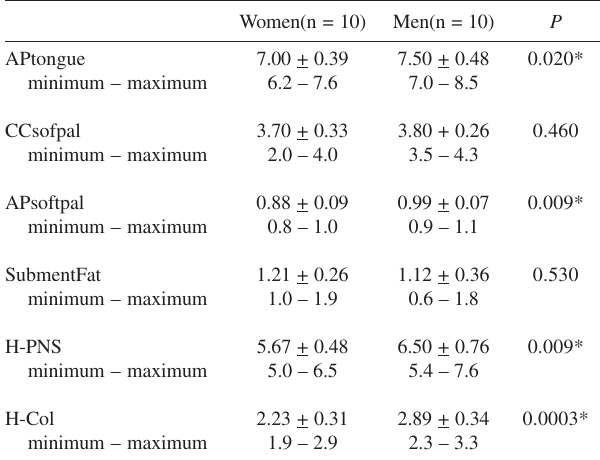
Table 1 - Sagittal pharyngeal measurements in healthy men and women (cm)